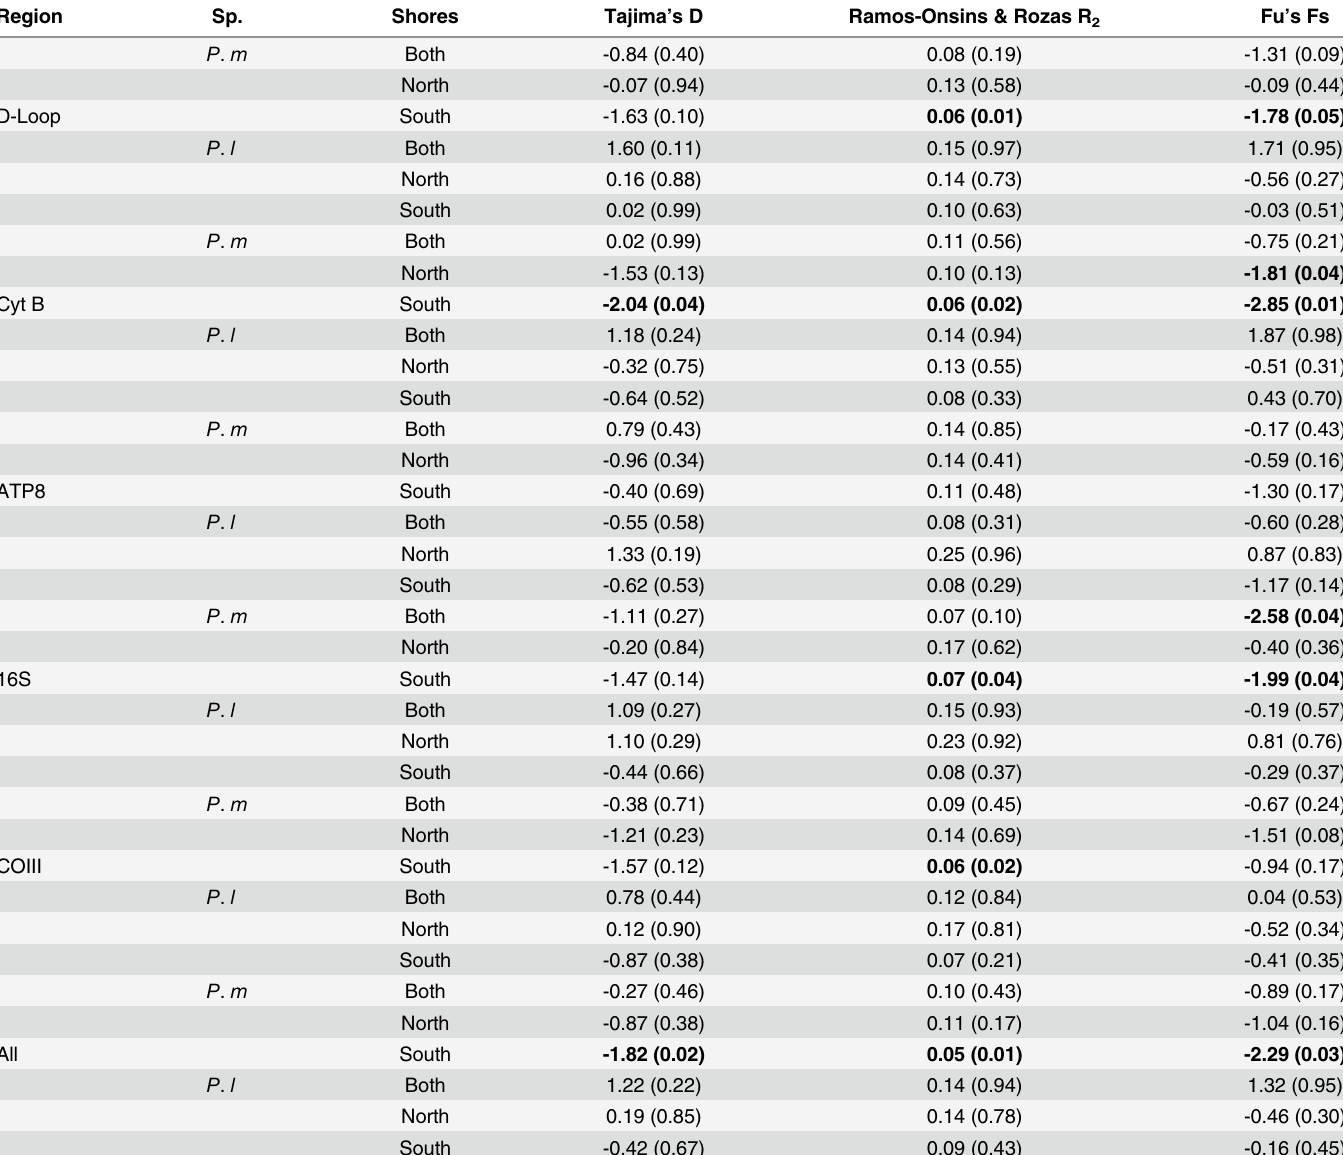
Table 4. Results of neutrality tests for both species ( P . m and P . l ) and all mtDNA regions, for both shores combined or analyzed separately, with corresponding probability values (in parentheses). Significant values are in bold. Region